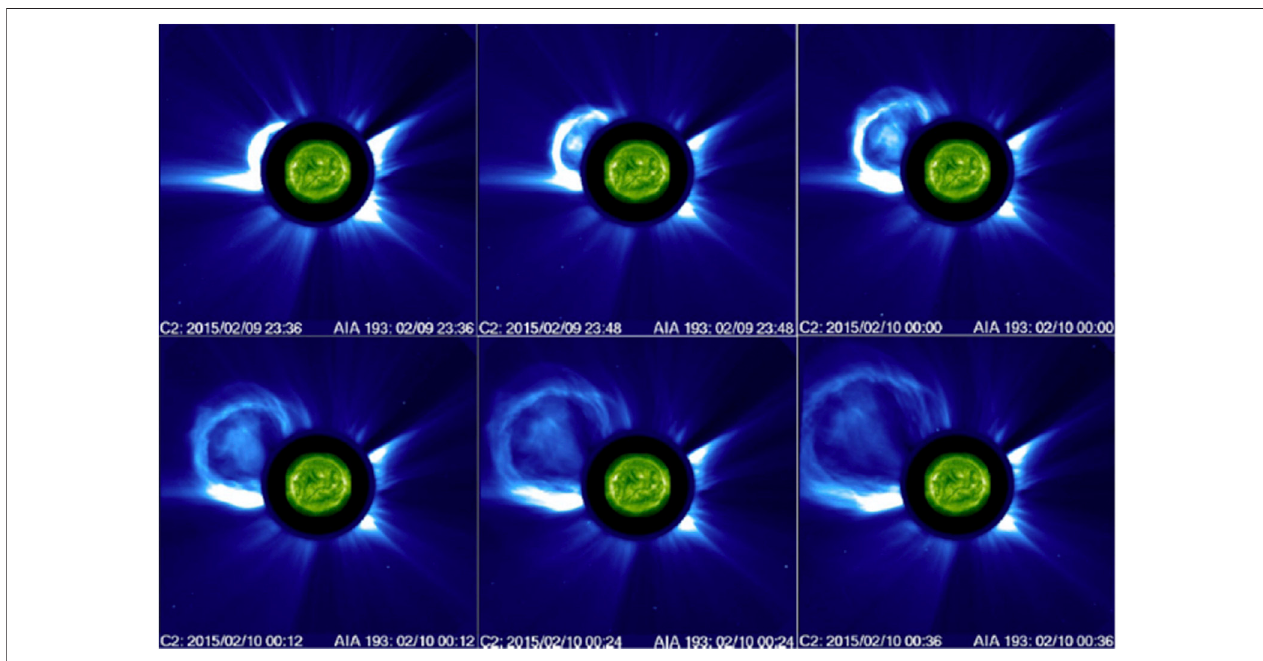
FIGURE 4 | 60 min propagation of a CME as imaged by the LASCO/C2 coronagraph aboard the SOHO spacecraft. Notice the idealized structure present in the image of a bright inner core, a dark cavity region, and a bright outer loop (Georgoulis et al., 2019).